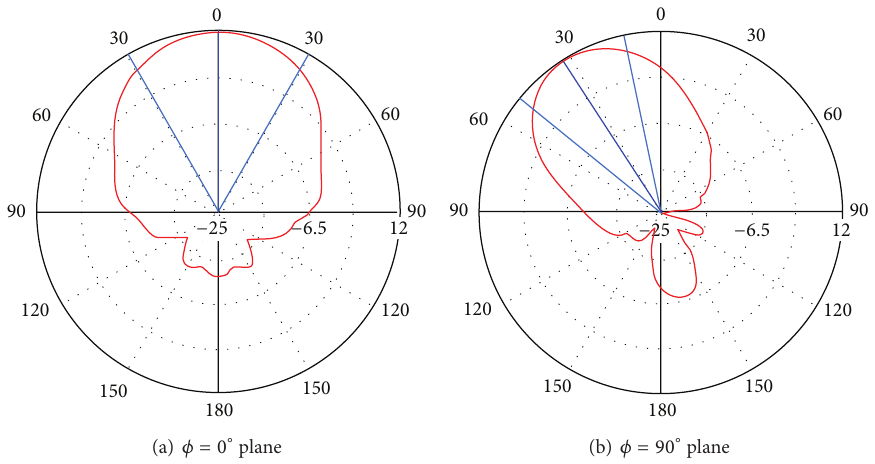
Figure 5: Gain patterns of the proposed Vlasov antenna (using CST).